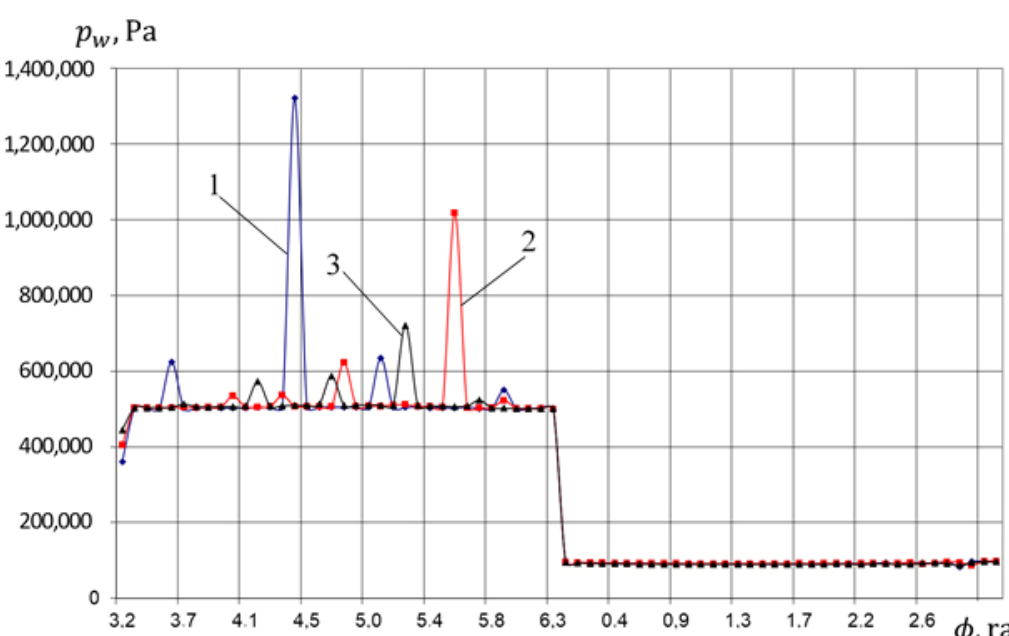
Figure 19. The indicator diagram of the compressor section at different speeds of the crankshaft (1— (cid:1866) (cid:3045)(cid:3032)(cid:3049) = 400 rpm ; 2— = 500 rpm ; 3— (cid:1866) = 600 rpm ). (cid:1866) (cid:3045)(cid:3032)(cid:3049) (cid:3045)(cid:3032)(cid:3049)